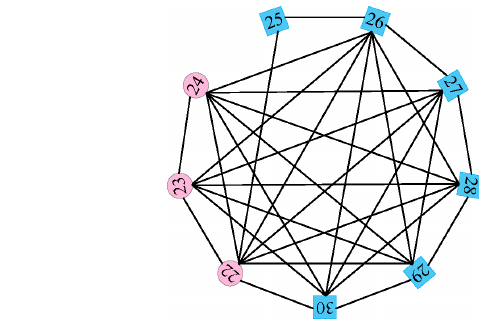
( a ) Topology of the IEEE 30-bus system ( b ) Topology of the reduced IEEE 30-bus system Figure 10. IEEE 30-bus system before and after reduction. ( a ) Description of the order of nodes of the IEEE 30-bus system. ( b ) Description of simplified topology of the IEEE 30-bus system. Table 1. Line impedance of the reduced IEEE 30-bus